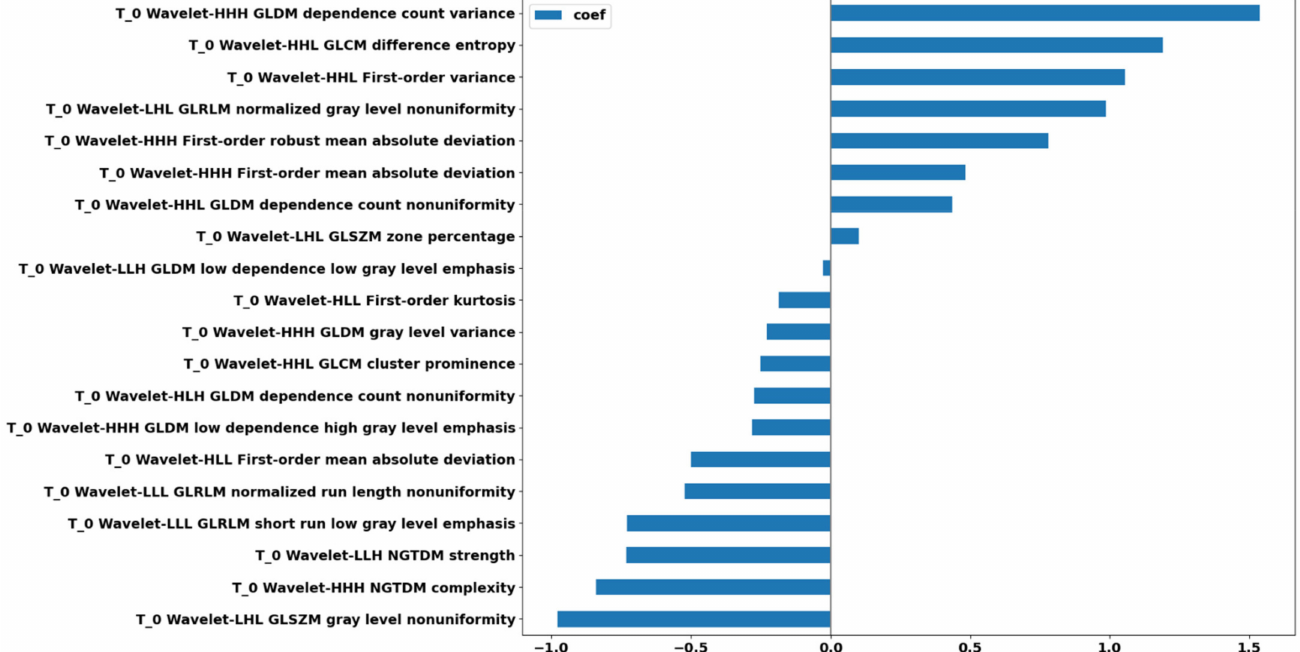
Figure 7. Feature ranking of the 20 selected radiomics features after feature reduction based on the regression coefficient